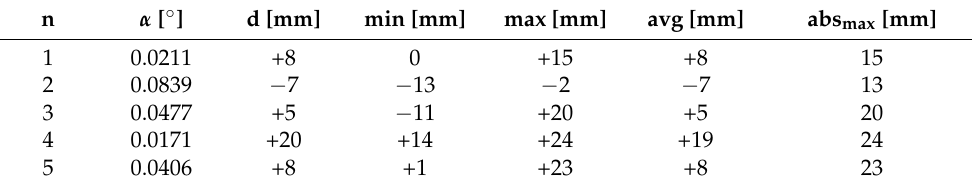
Table 1. Differences between the as-planned and the as-built model for the selected